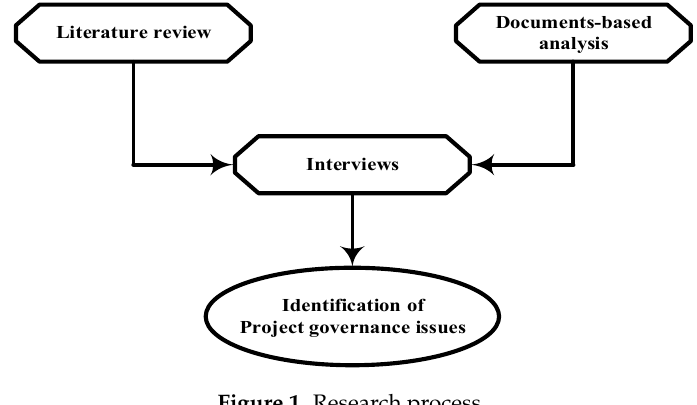
Figure 1. Research process.